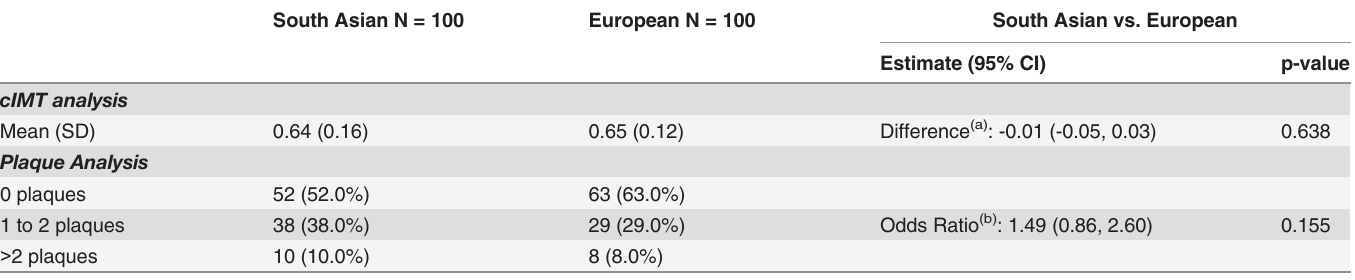
Table 3. Differences in cIMT and plaque scores between South Asian and European